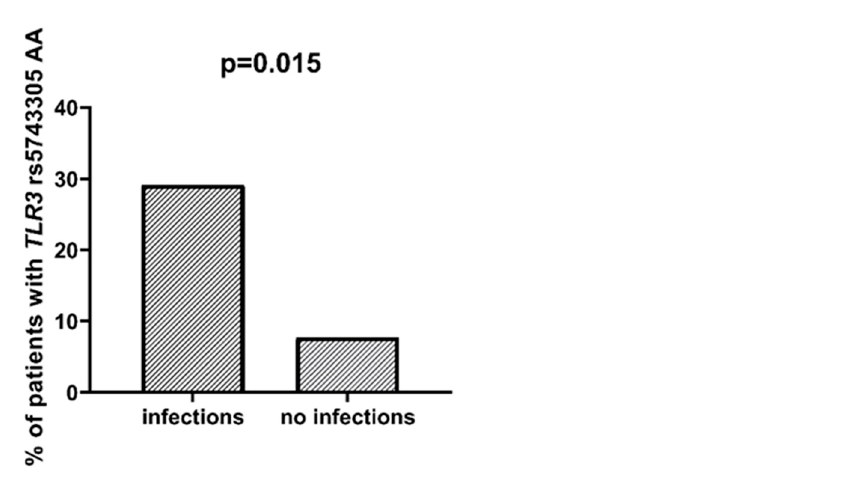
Figure 3. CRP level in patients with and without TLR9 rs5743836 C .